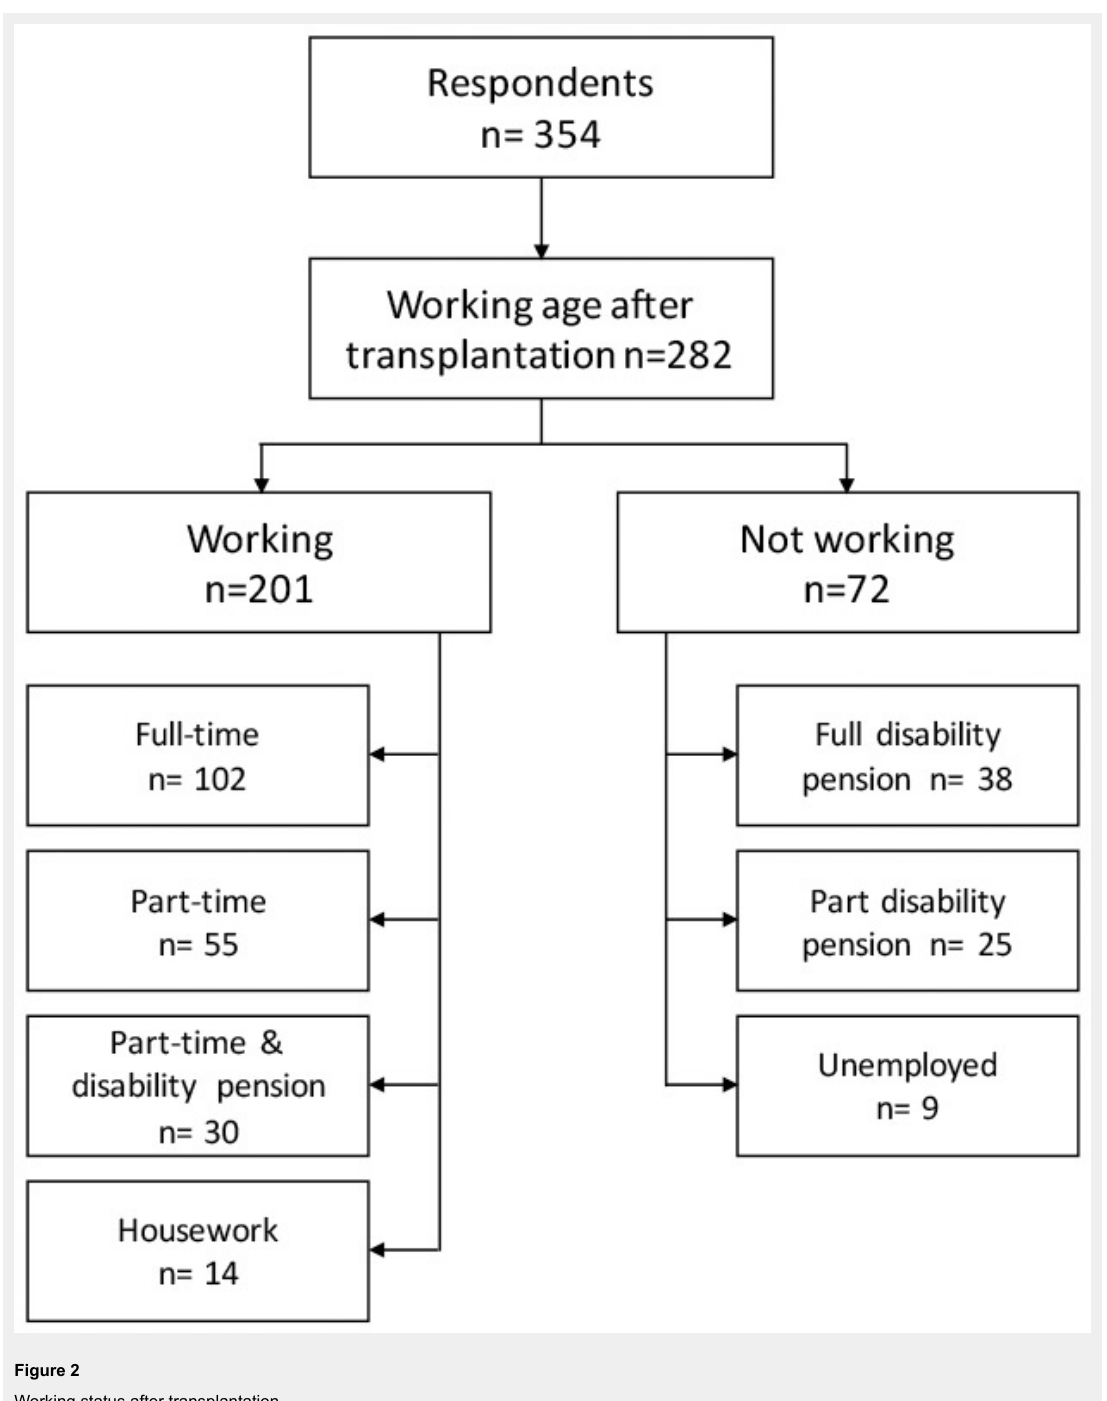
Figure 2 Working status after